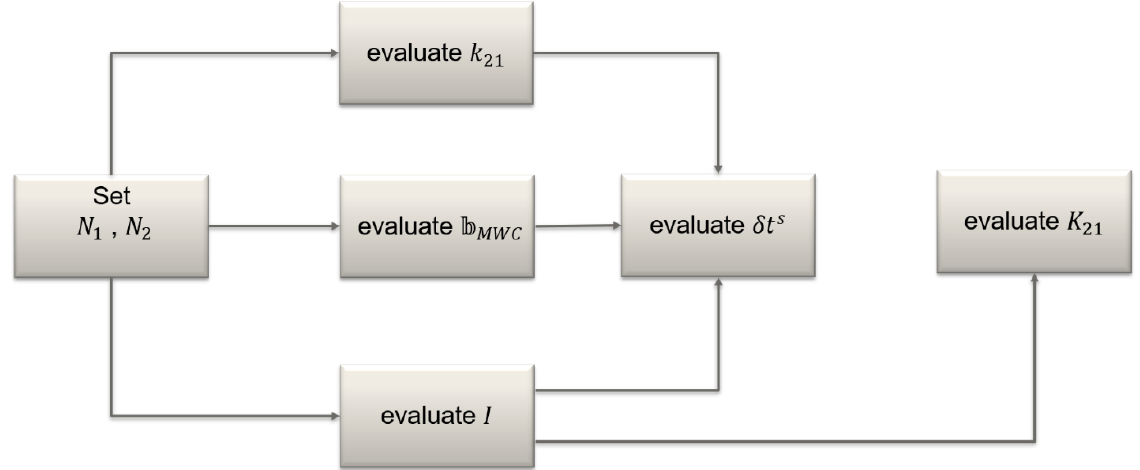
Figure 2. Flowchart of experimental correction generation.